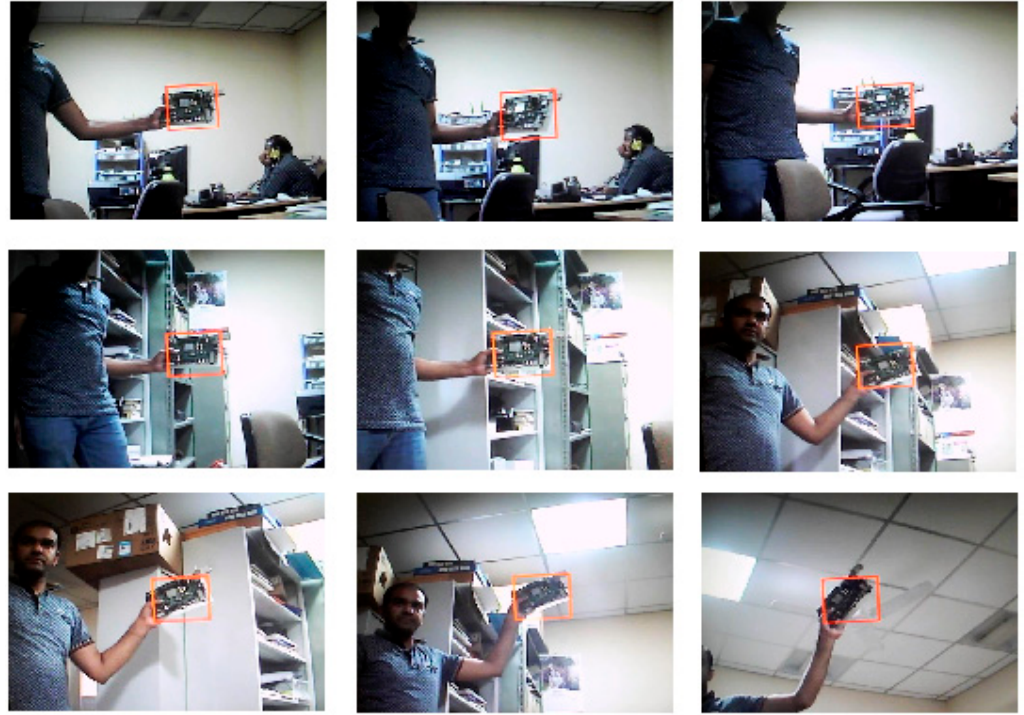
Figure 19. Frame sequence showing object tracking in scenes that change due to camera movement and presence of other moving objects in the scene.